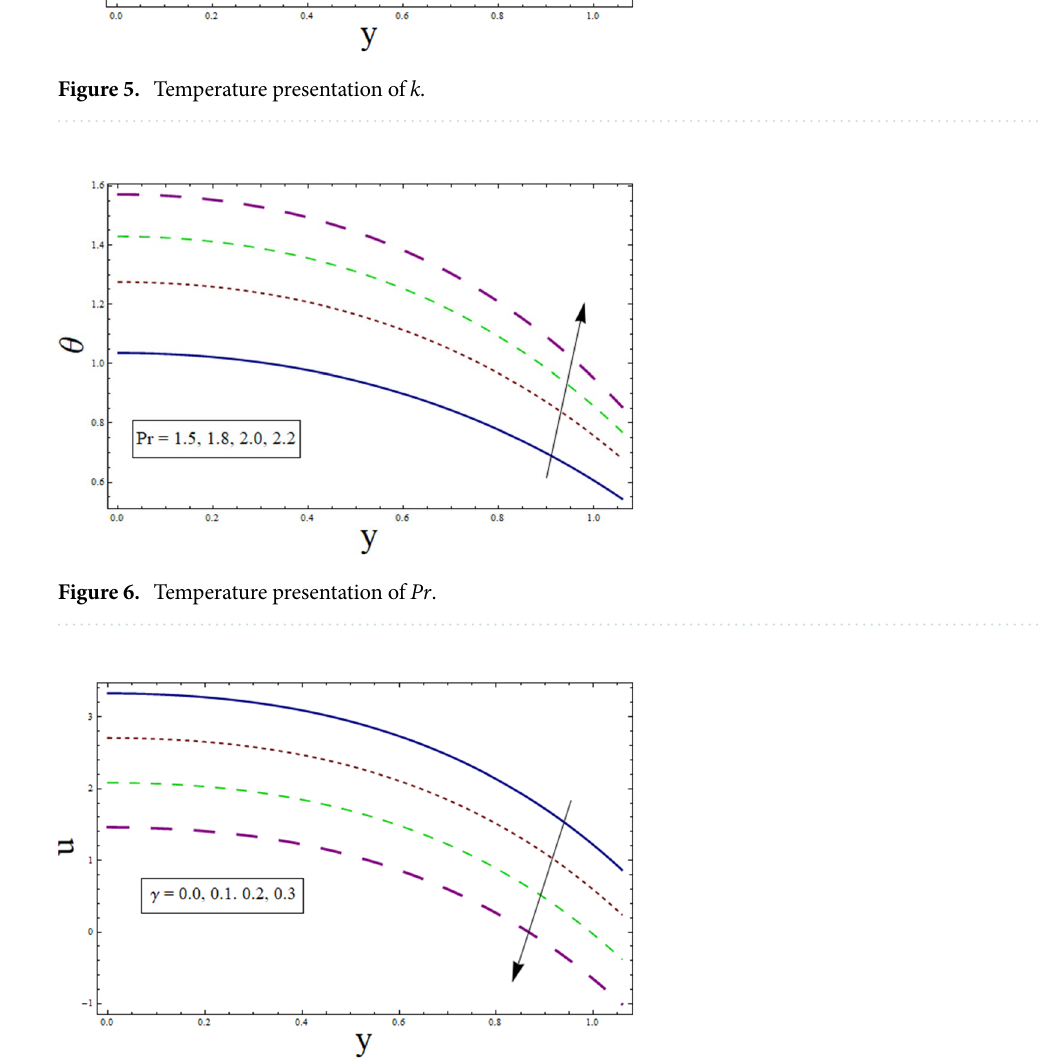
Figure 7. Velocity presentation of γ